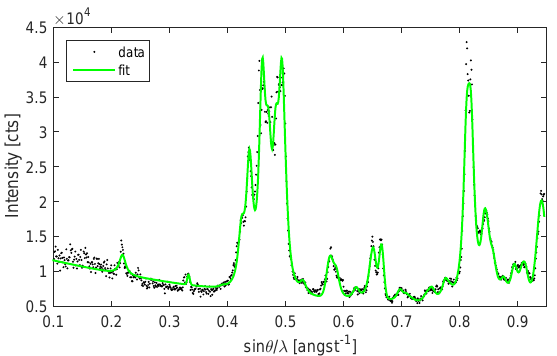
Figure 4. Demonstration of fit in one sector. of lines from different sectors and in the number of lines which were taken into account.